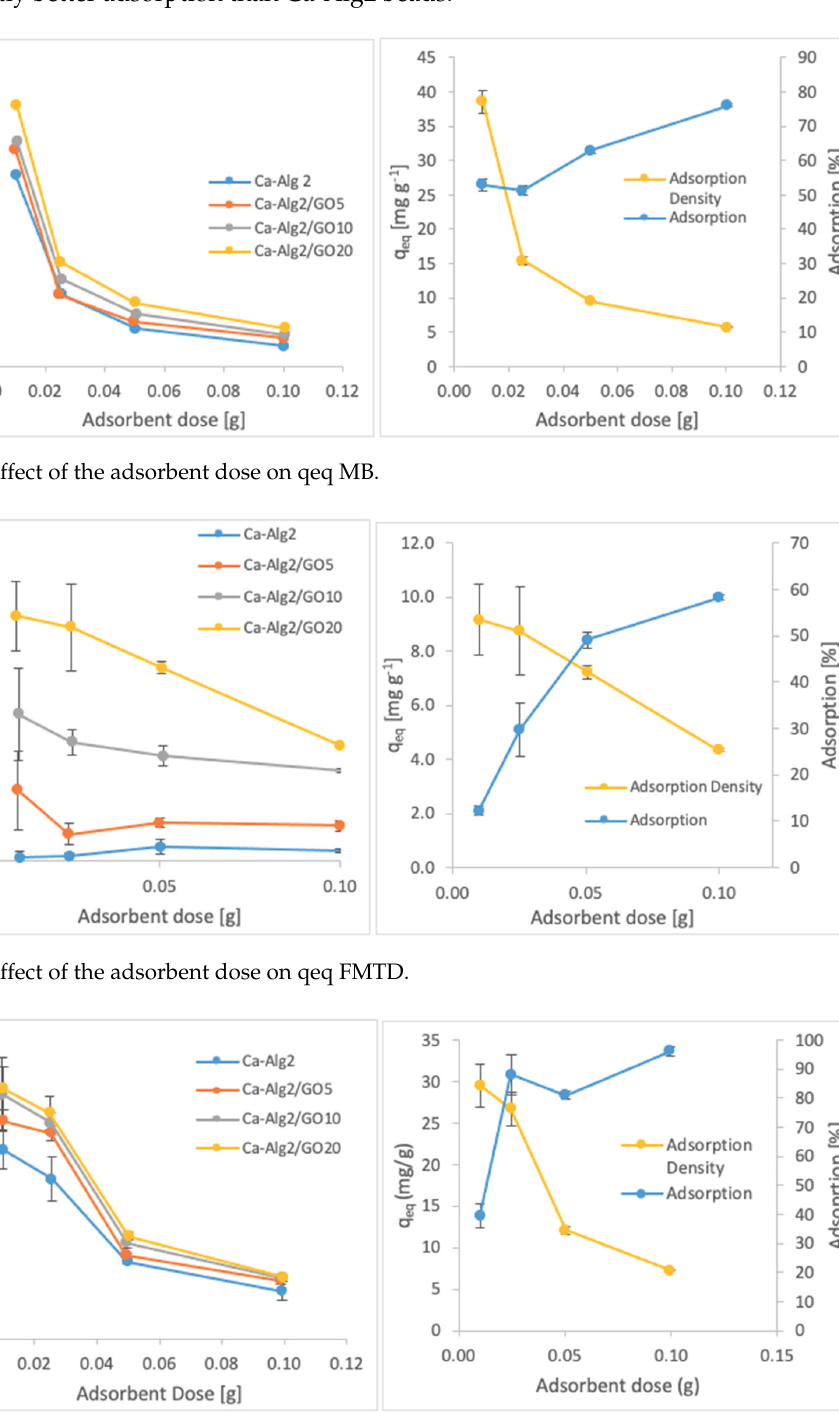
Figure 9. Effect of the adsorbent dose on qeq DFC.